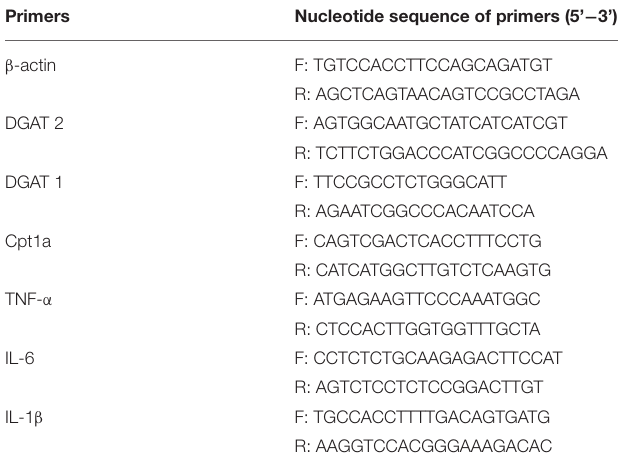
TABLE 1 | Primers for this study. Primers Nucleotide sequence of primers (5’ −